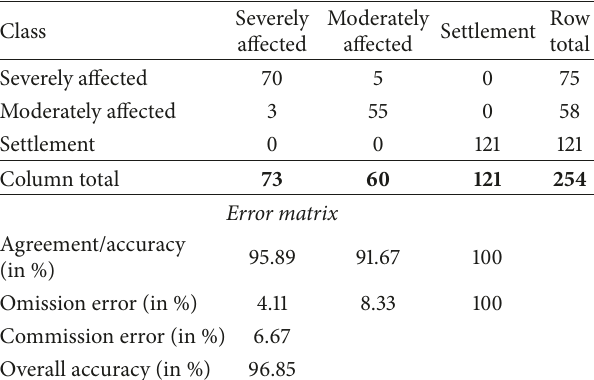
Figure 1: Location map of study area (Sirsa district of Haryana, India).